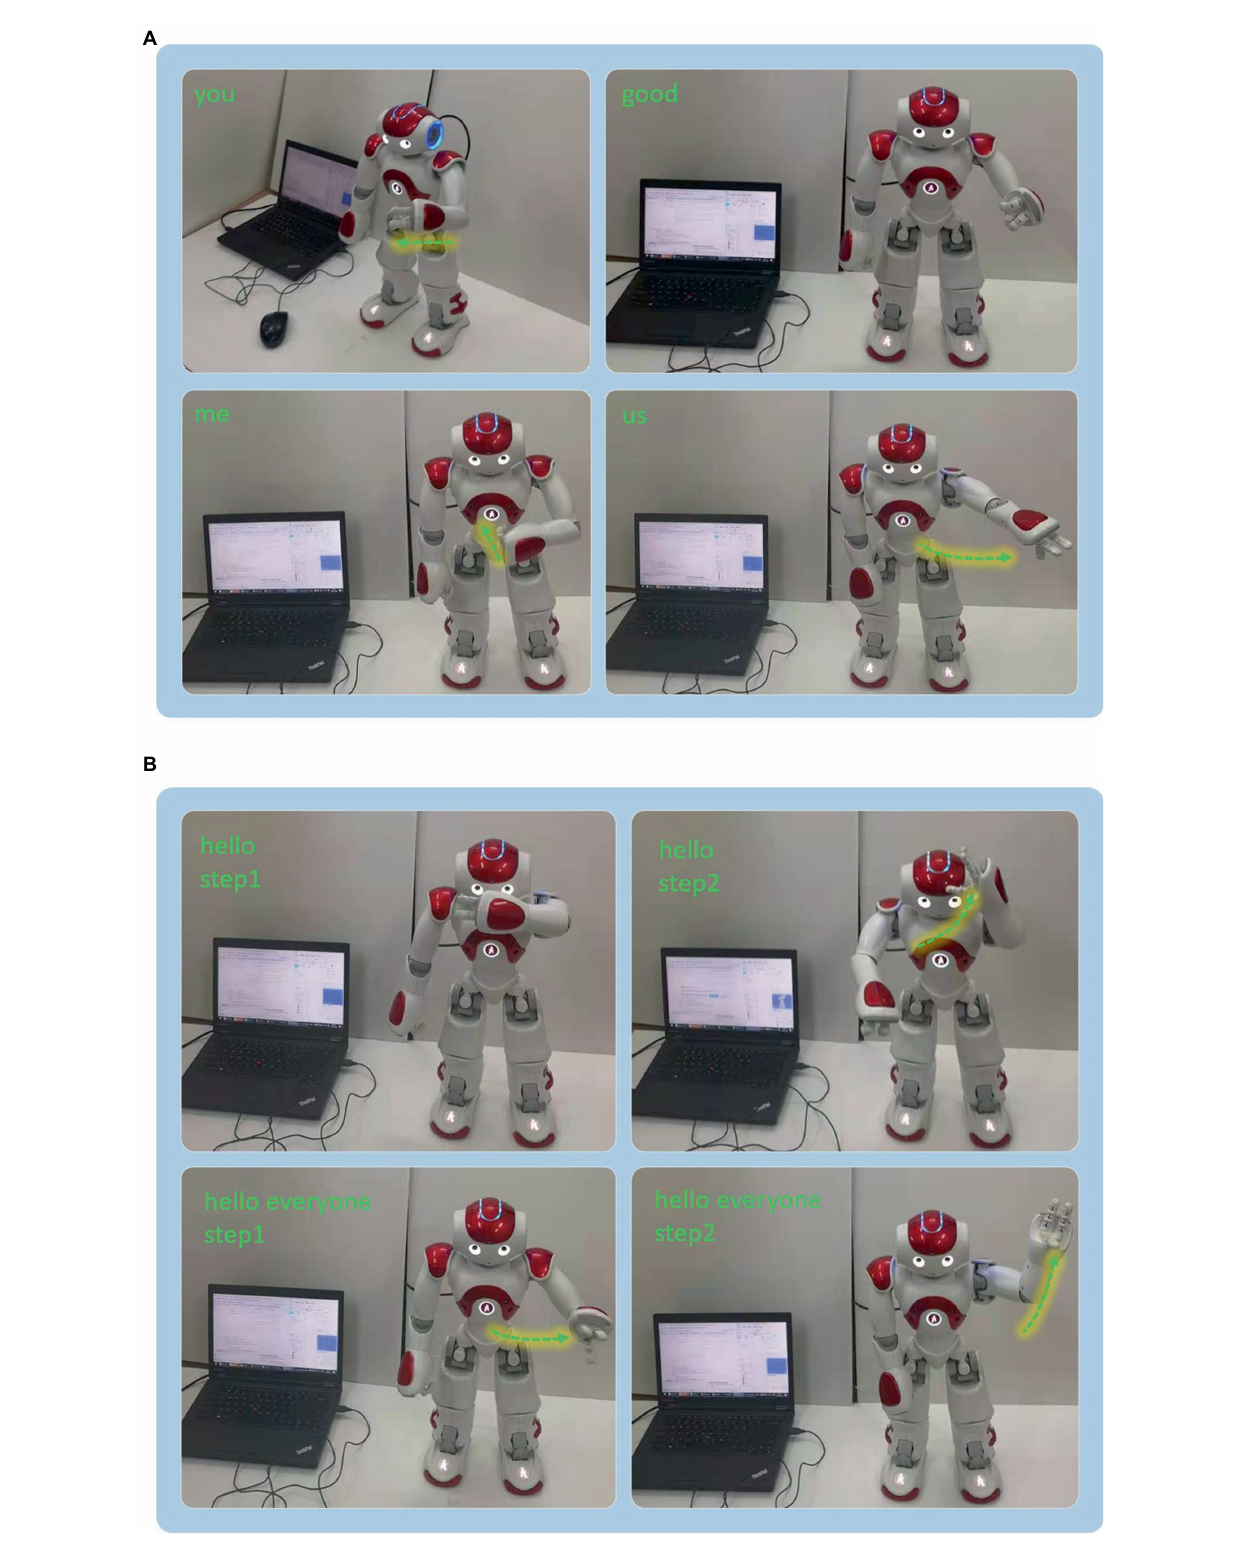
FIGURE 13 The NAO robot interaction results of experiment 2. (A) Robot response results of the four singular hand gestures. (B) Robot response results of the two combination